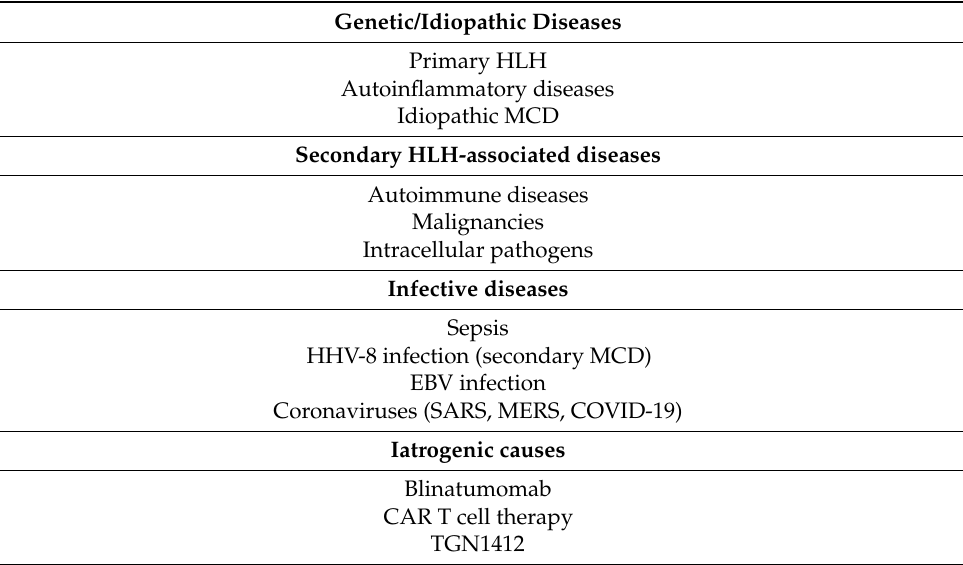
Table 1. Clinical conditions associated with cytokine storm. Abbreviations: HLH, hemophago- cytic lymphohistiocytosis; MCD, multicentric Castleman disease; HHV-8, human herpesvirus 8; EBV, Epstein-Barr virus; SARS, severe acute respiratory syndrome; MERS, Middle East respiratory syndrome; COVID-19, coronavirus disease 2019; CAR, chimeric antigen receptor. Genetic/Idiopathic Diseases Primary